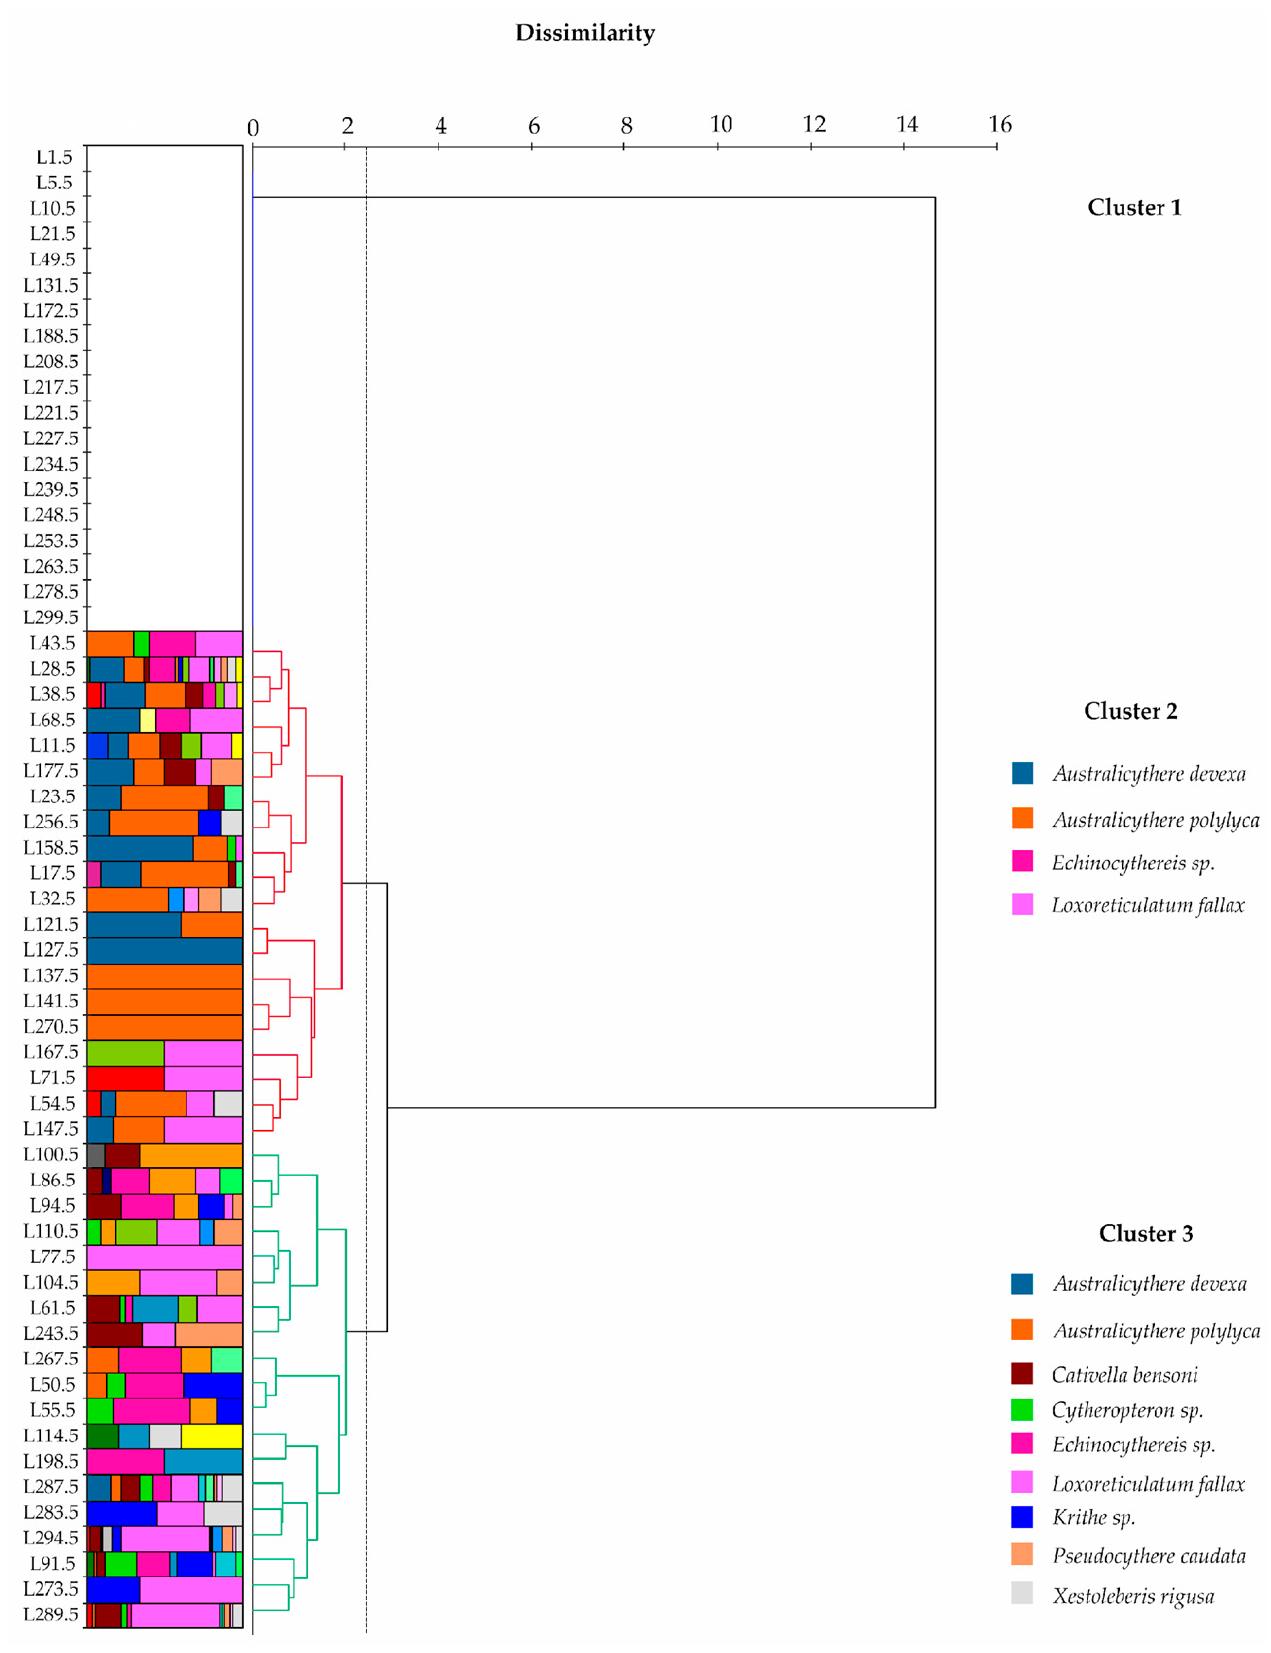
Figure 3. Q-mode cluster analysis (Ward’s method; Bray–Curtis algorithm): the dominant species for each cluster are reported. Levels are given in cm.